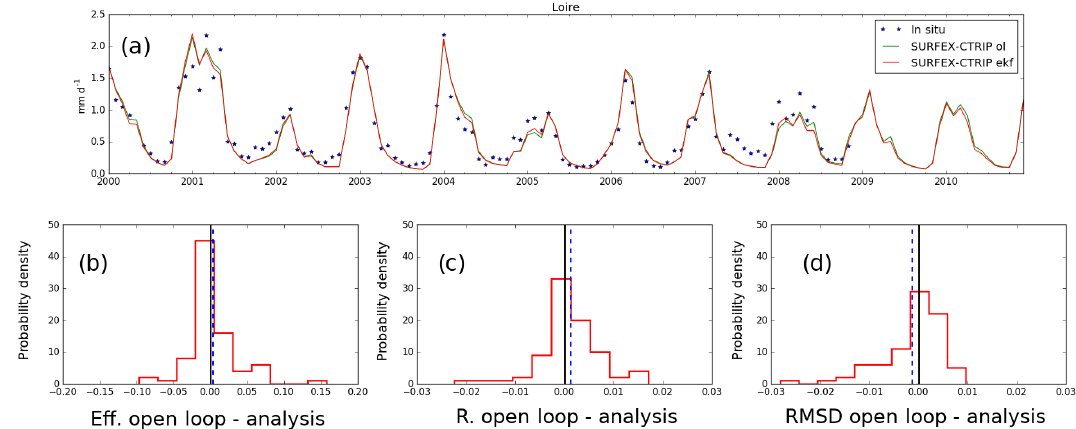
Figure 11. (a) Hydrograph for the Loire River in France (47.25 ◦ N, 1.52 ◦ W) representing scaled river discharge Q (using either observed or simulated drainage areas), in situ data (blues dots), open loop (green solid line) and analysis (red solid line); (b–d) histograms of efficiency, correlations and RMSD differences between Q from the open loop and the analysis compared to the observations for the 83 stations retained (see Sect. 2.2.3 on evaluation